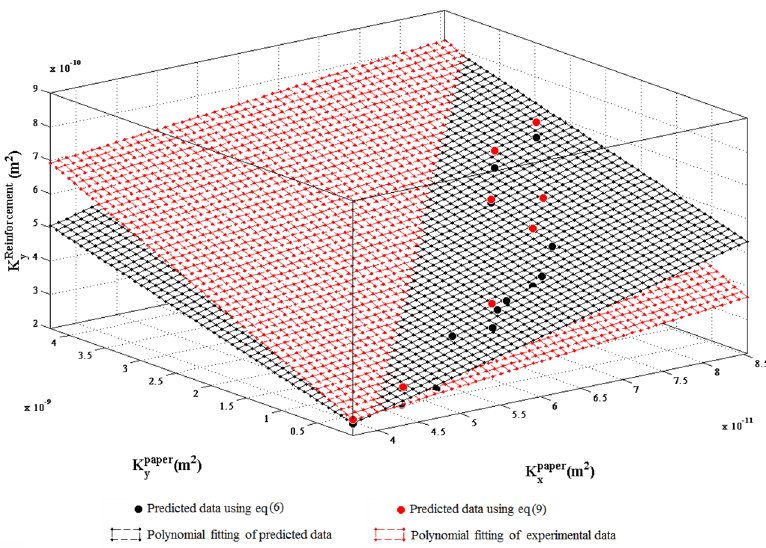
Figure10. Comparison between experimental data and predicted K y using Equations (6) and (9).